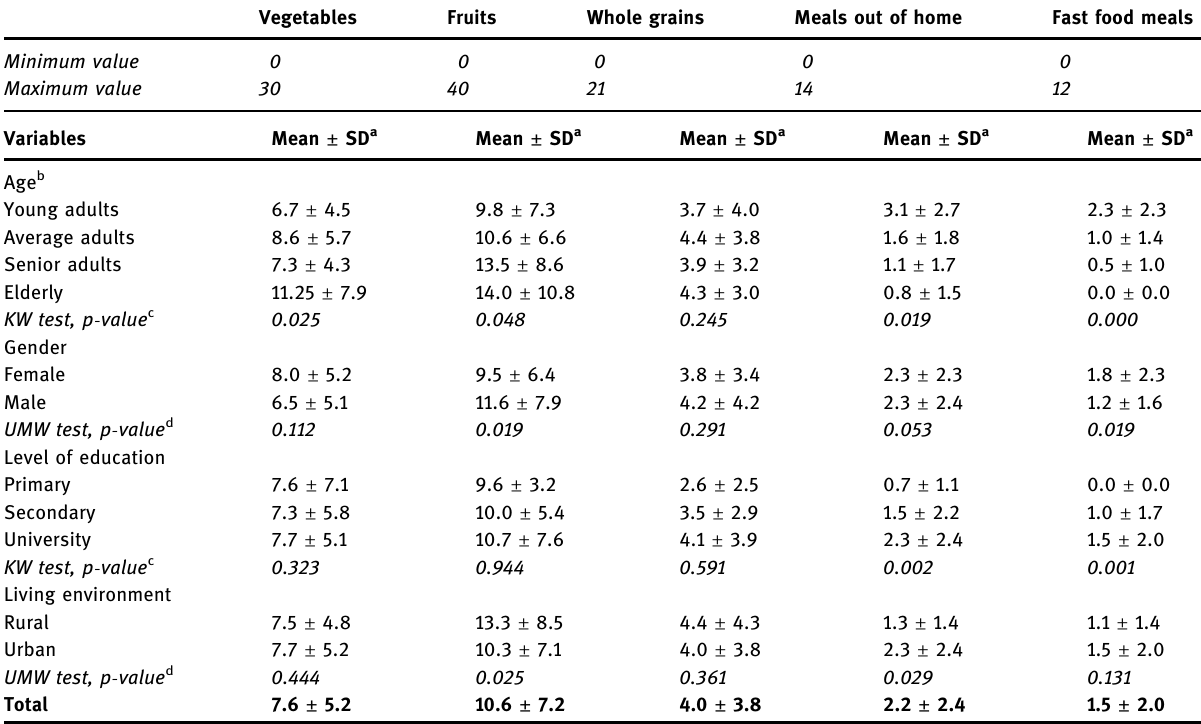
Vegetables Fruits Whole grains Meals out of home Fast food meals